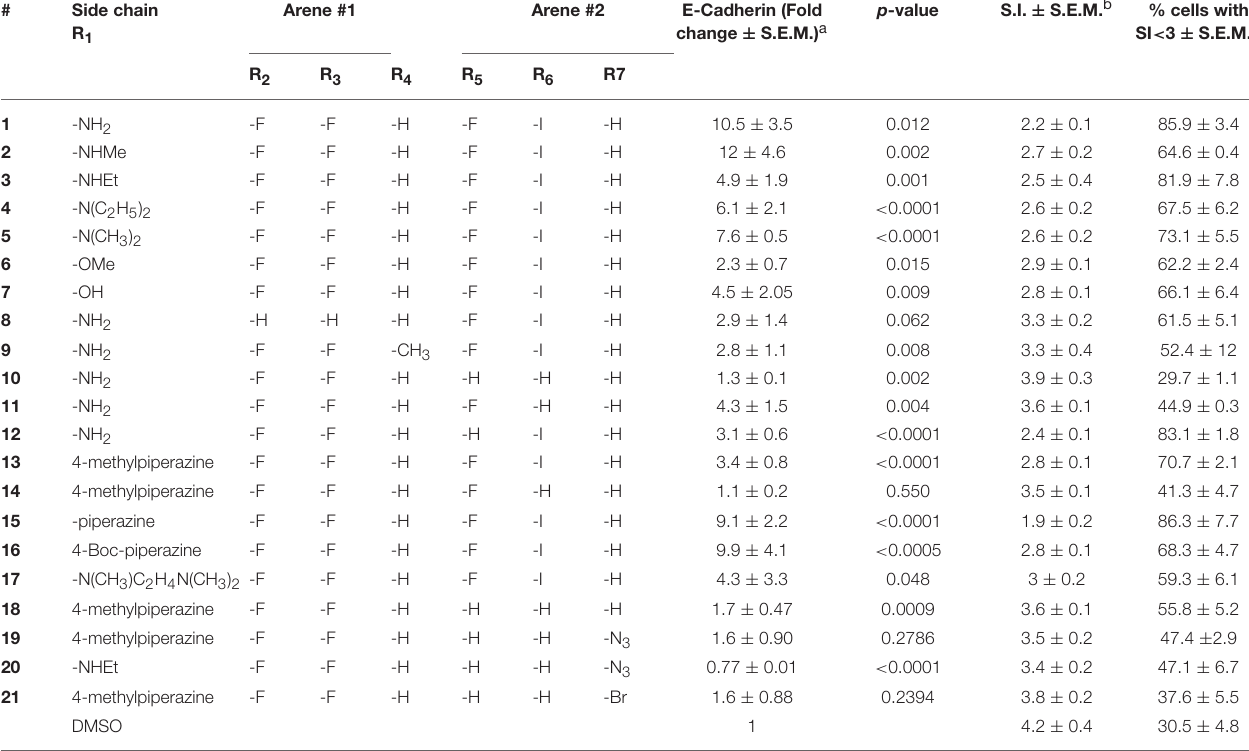
TABLE 1 | Effect of diphenylamine derivatives on E-Cadherin, mean spindle index, and % cells with SI < 3 in MDA-MB-231 cells. # Side chain R